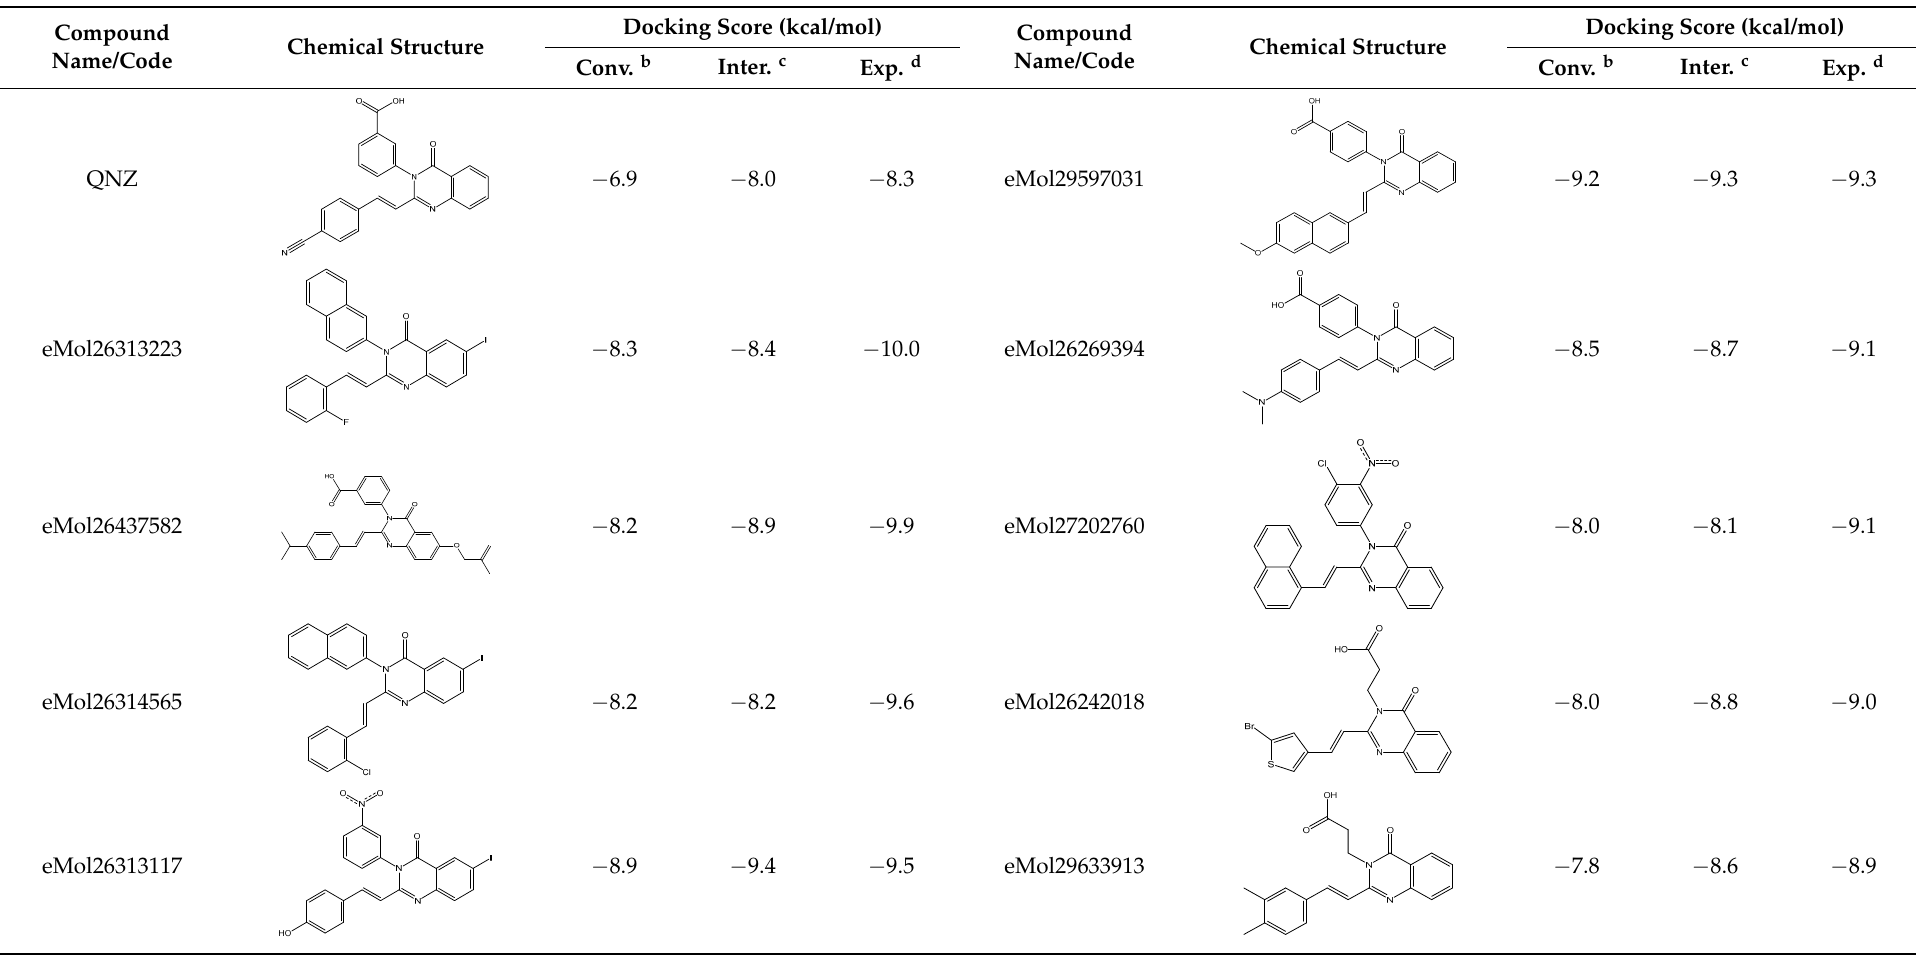
Table 2. Estimated conventional, intermediate, and expensive docking scores and 2D chemical structures for QNZ and the top 35 potent inhibitors against mutated PBP2a allosteric site in acidic medium a . Compound